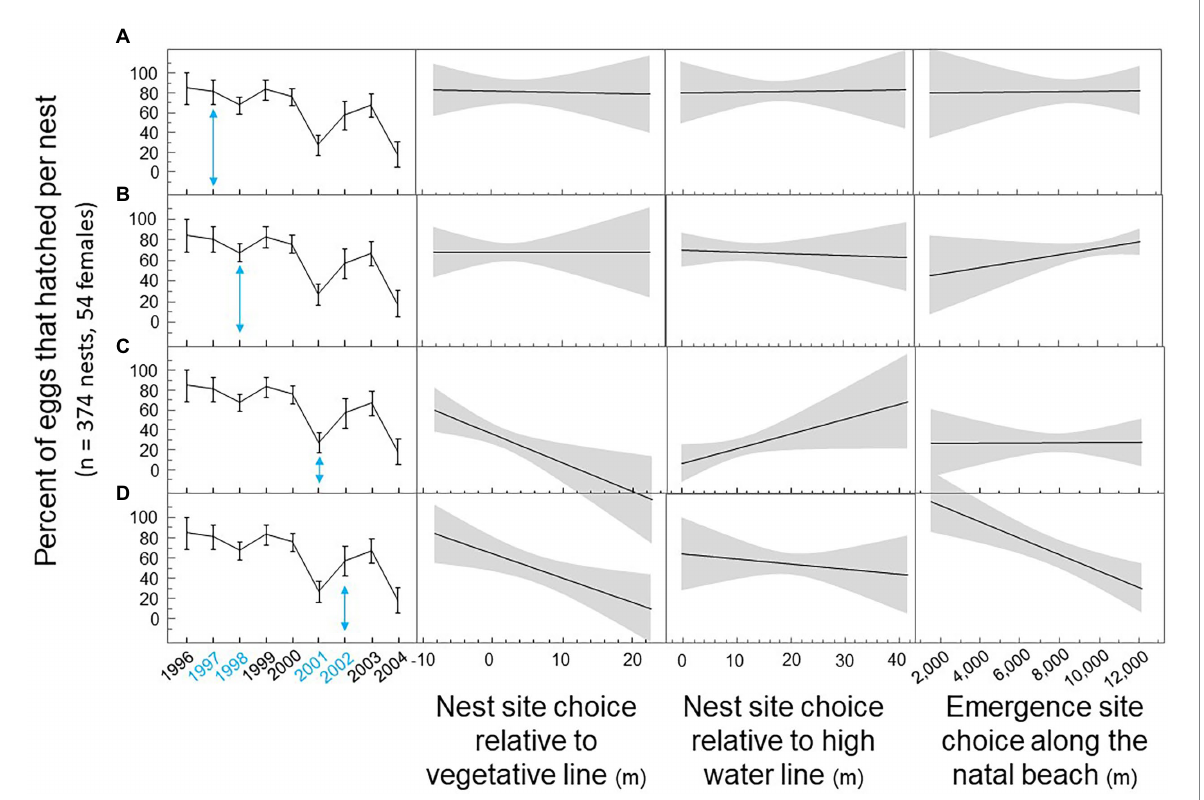
FIGURE 3 Nest site choice on Keewaydin Island by loggerhead females during multiple breeding seasons from 1996 through 2004. (A) Hatching success by nest site choice in 1997. (B) Hatching success by nest site choice in 1998. (C) Hatching success by nest site choice in 2001. (D) Hatching success by nest site choice in